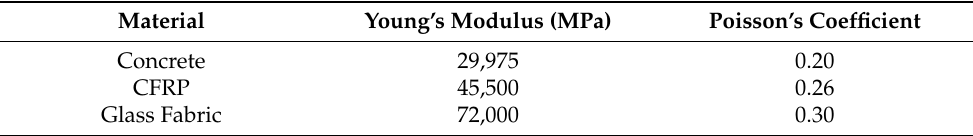
Table 2. Mechanical properties of the concrete, CFRP, and glass fabric for numerical